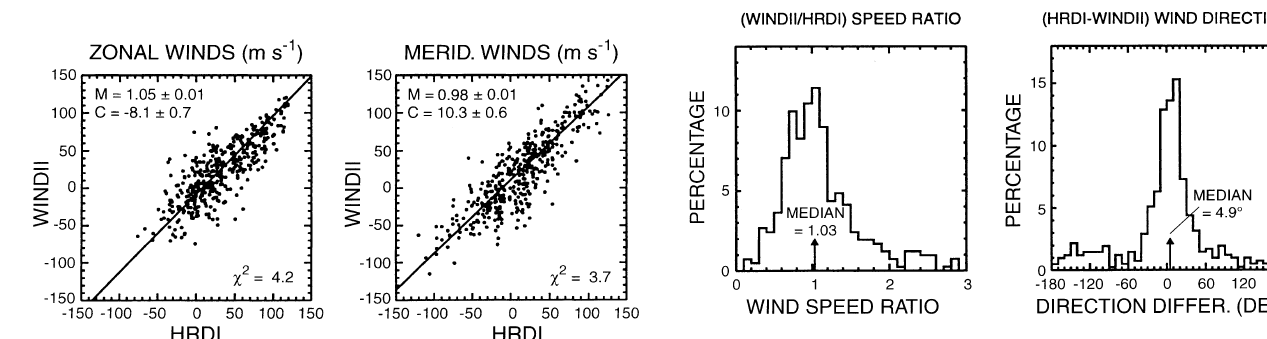
Fig. 2. WINDII/HRDI wind-speed ratios ( left-hand panel ) and direction di(cid:128)erences ( right-hand panel ) presented as a percentage of all the available coincidences at an altitude of 95 km (total of 412) on 17 January